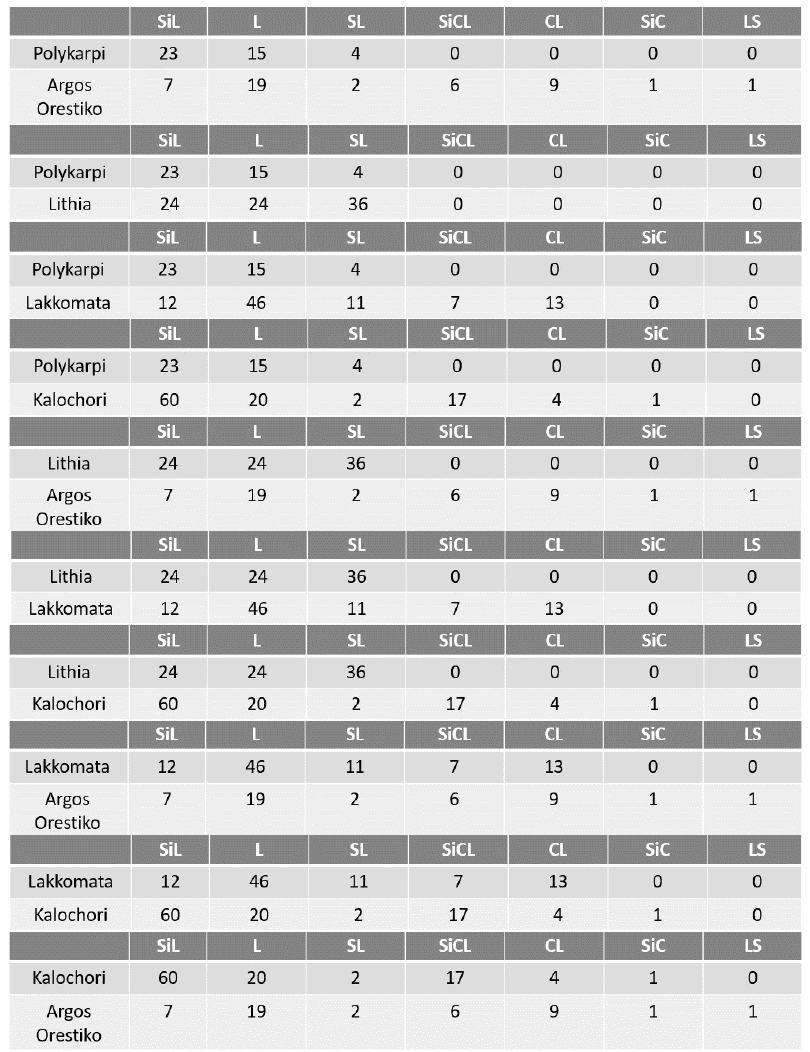
Table 1. Contingency tables of Kastoria region